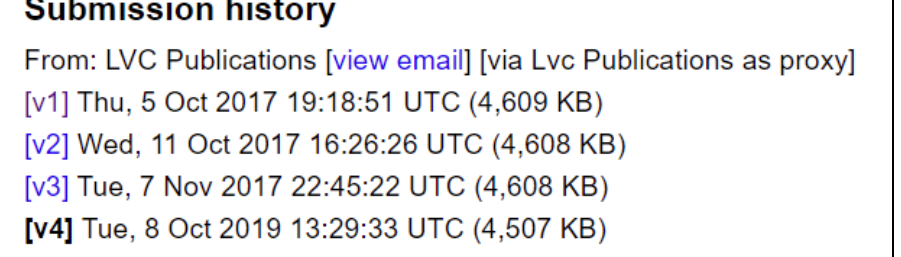
Figure 3. Four versions of the alive publication presented on the page https://arxiv.org/abs/1710.02185 (accessed on 1 September 2022).